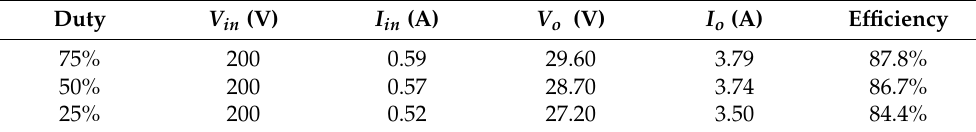
Table 5. DOM efficiency